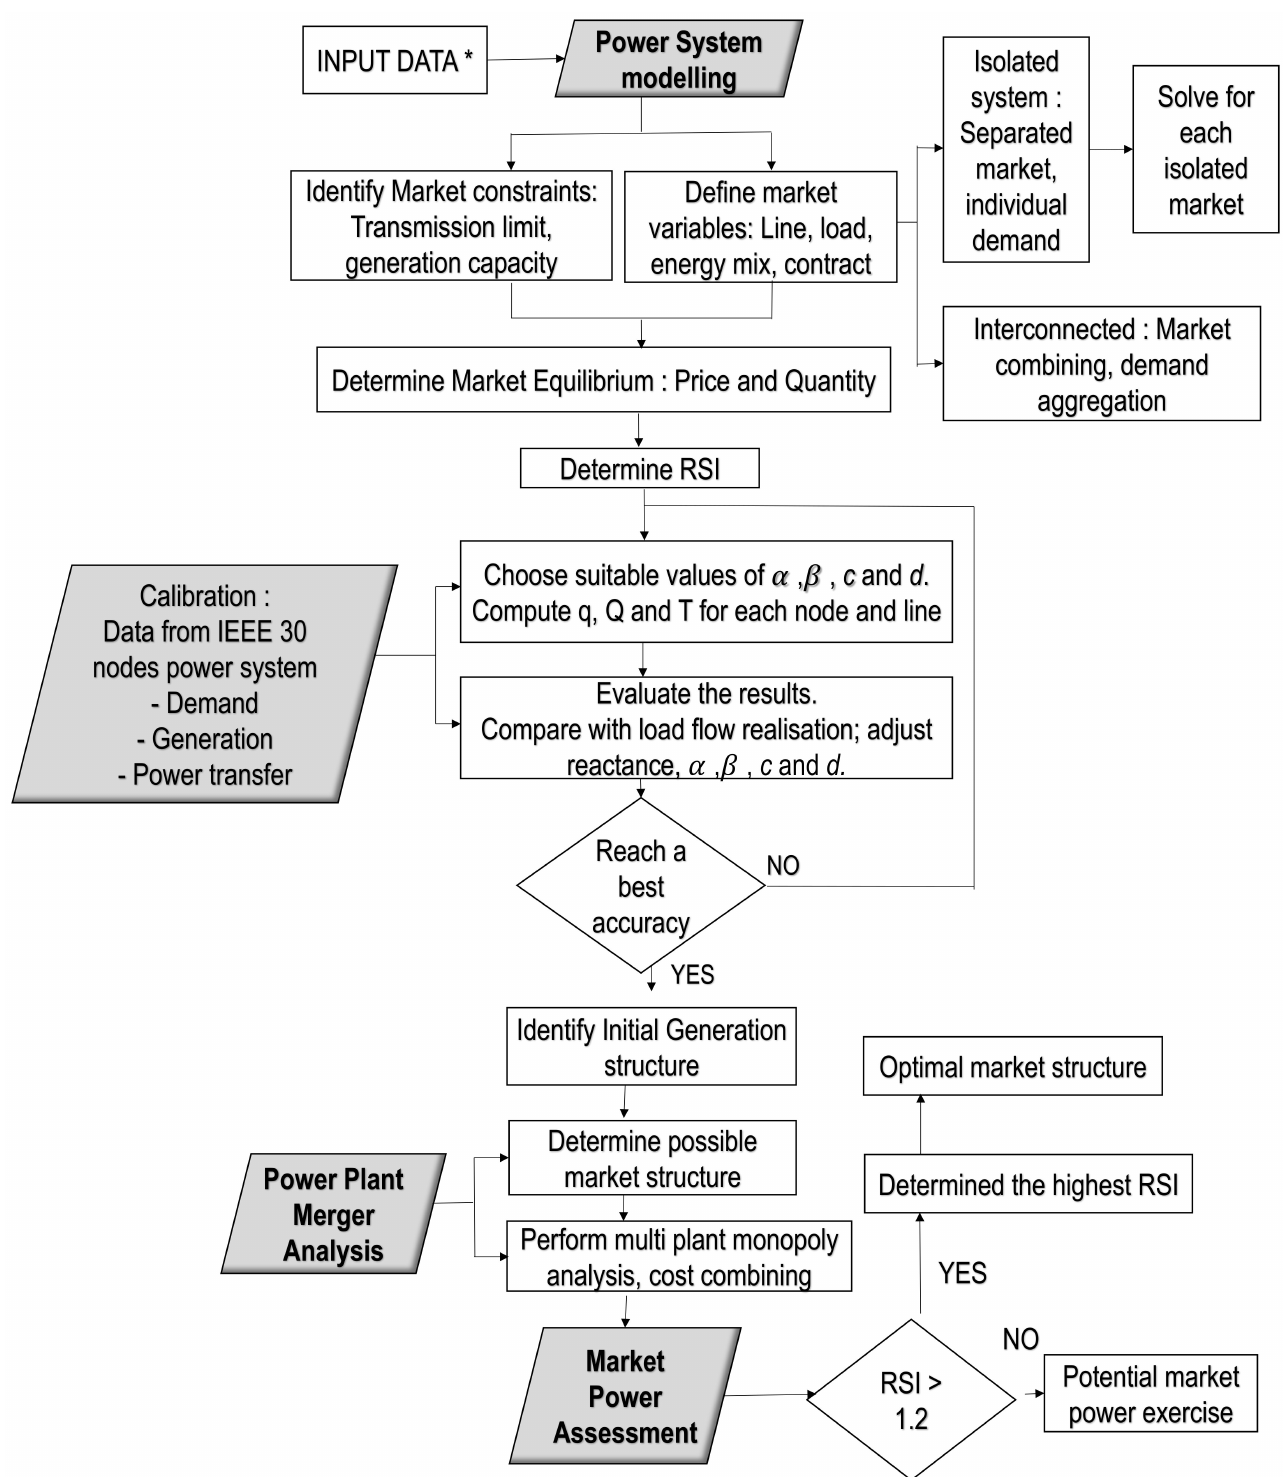
Figure 1. IEEE 30 bus test power